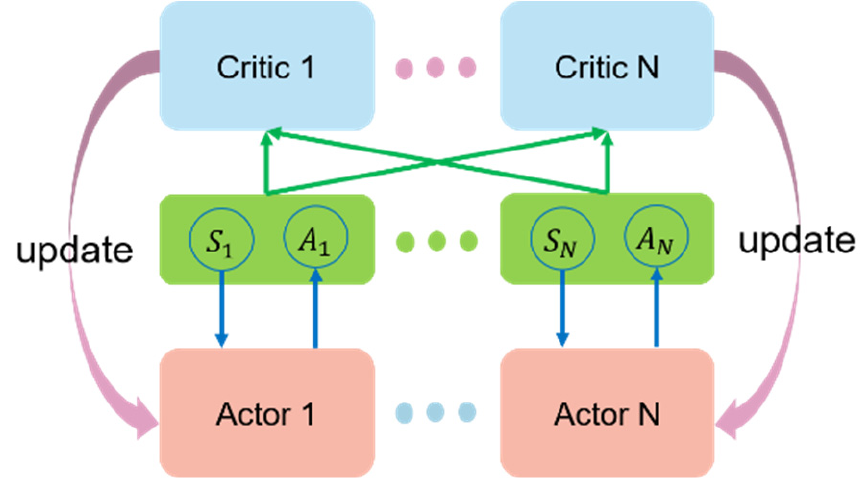
Figure 5. Multi-UAV DDPG algorithm.